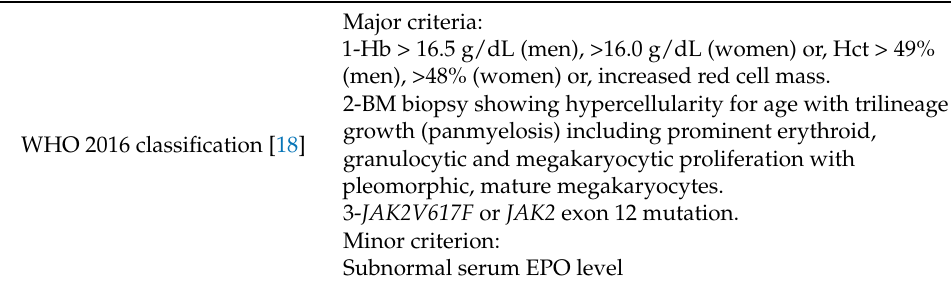
Table 1. Classification criteria for PV diagnosis.